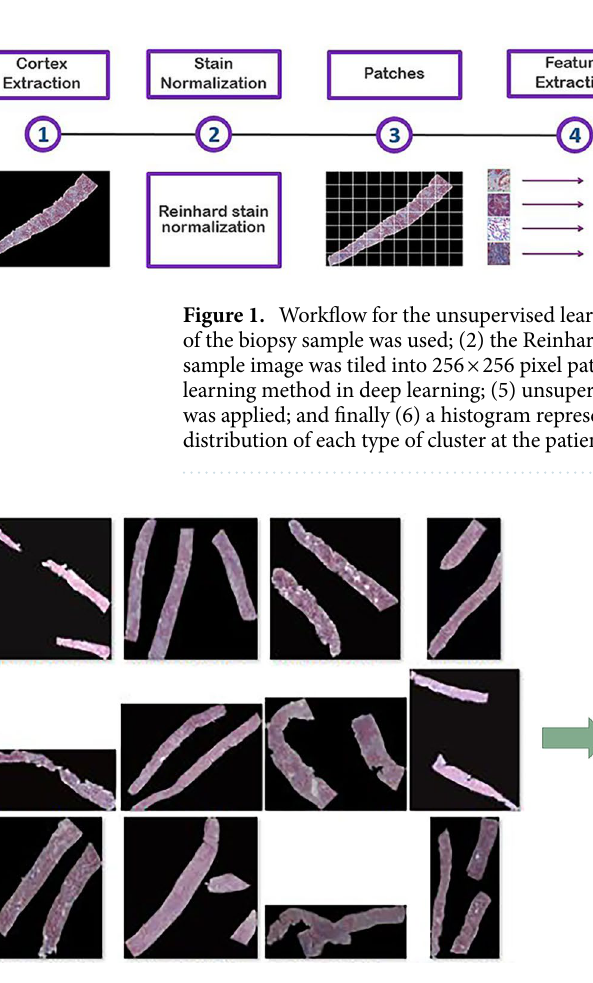
Figure 2. Example images of biopsy samples. Multiple cortexes are combined in each case. To reduce the color and intensity variations present in the stained images, we computed the global mean and standard deviation of each channel in the Lab color space for the Reinhard color normalization for all data and used them as reference values to normalize our data. The figure shows Reinhard color normalization before (left) and after